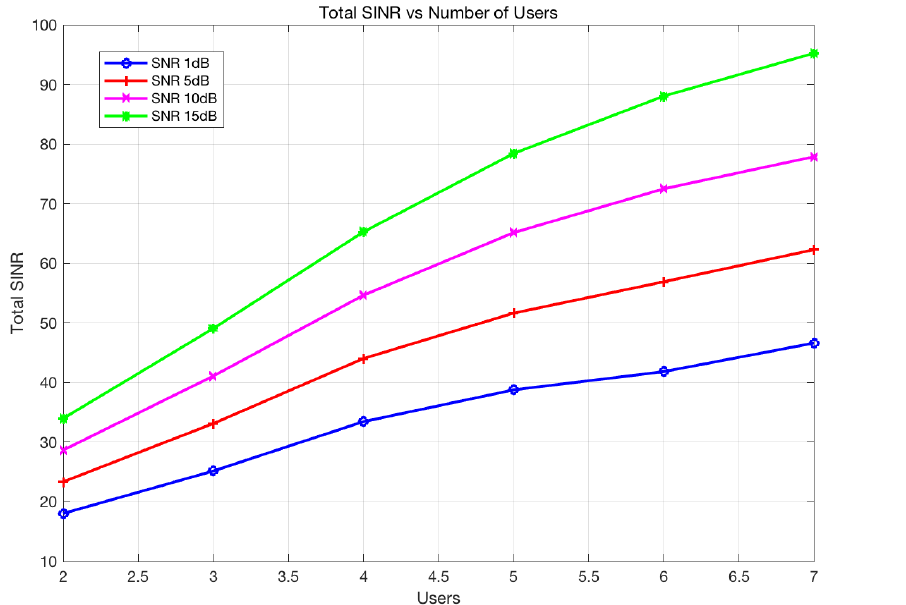
Figure 6. System SINR performance comparison as a function of the number of users for the proposed design. The user-desired DoF is